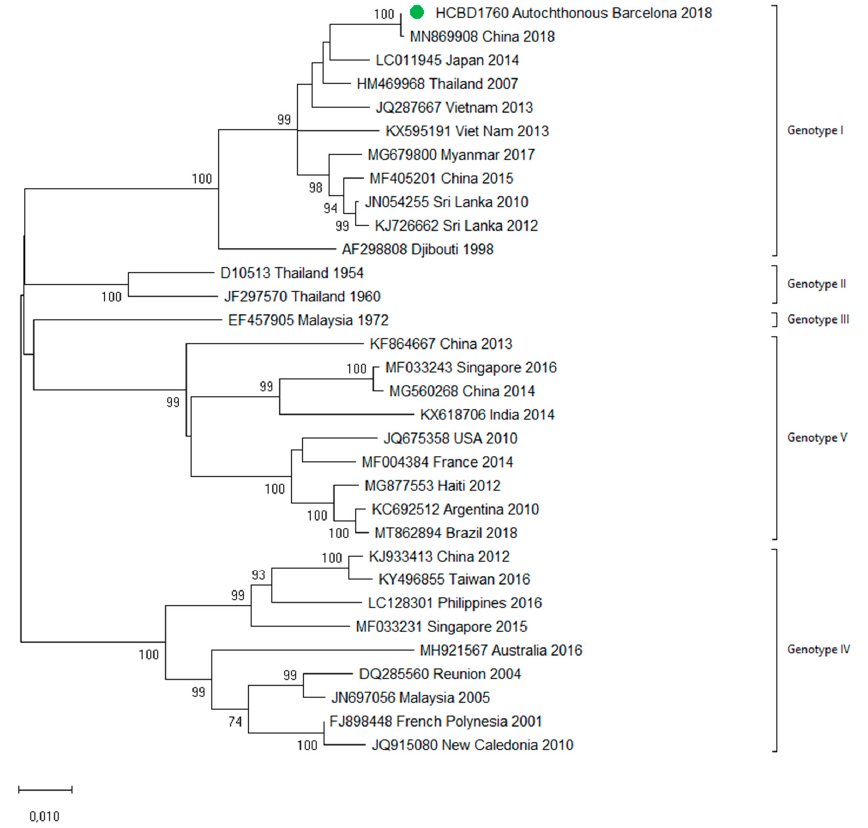
Figure 7. Phylogenetic analysis of the locally transmitted DENV-1 strain based on complete E and NS1 genes. Strains are denoted by the GenBank accession number, place and year of isolation. The green dot indicates the strain of the autochthonous case and the scale bar indicates substitutions per site. The analysis was performed using the maximum likelihood method (TN93 + I) with a bootstrap of 1000 replicates.